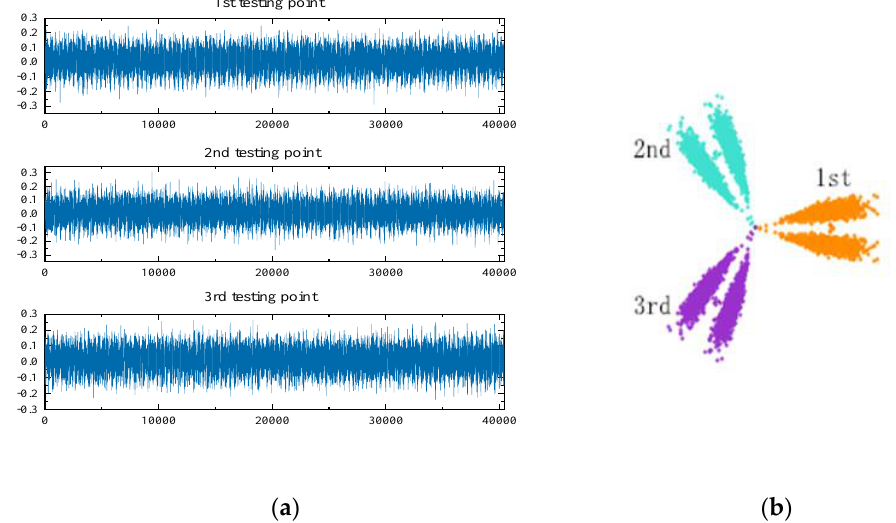
Figure 3. SDP method for converting each measurement point. ( a ) Original vibration signal. ( b ) SDP image conversion.